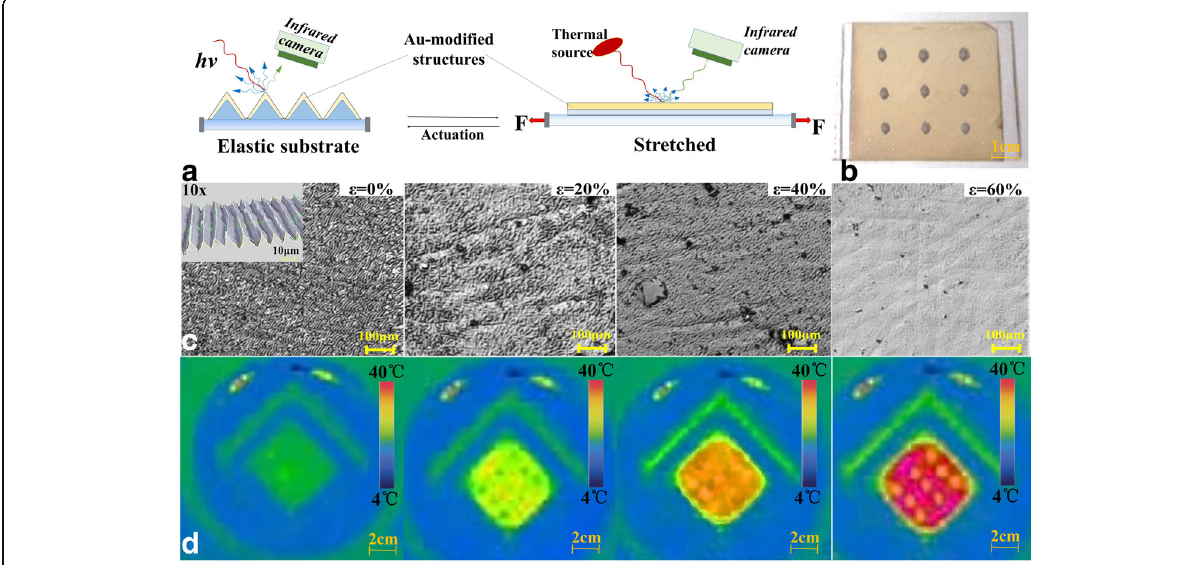
Fig. 5 Reversible stealth of Au-modified structures in the infrared. a Schematics of an Au-modified structures under a constant thermal flux (left) before and (right) after mechanical actuation. b Optical image of Au-modified structures. c The microscopic morphological characteristics for triangular wrinkle structures with increasing the strain. d The corresponding infrared camera images of the same Au-modified structures with increasing the